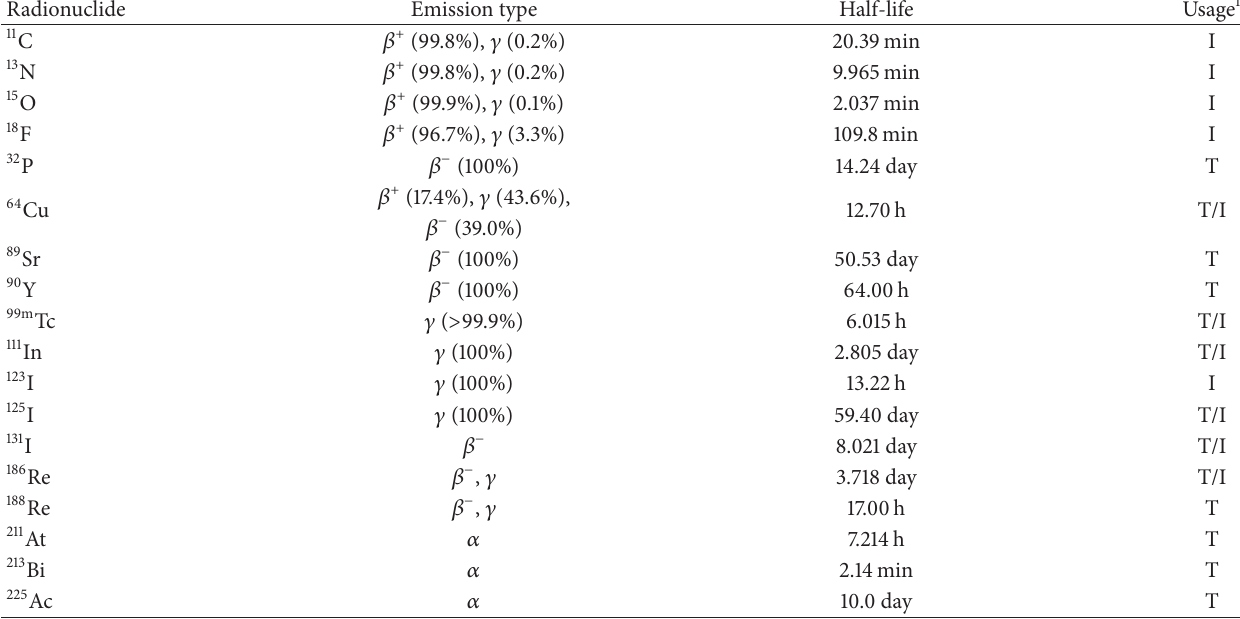
Table 1: Representative radionuclides used for imaging and